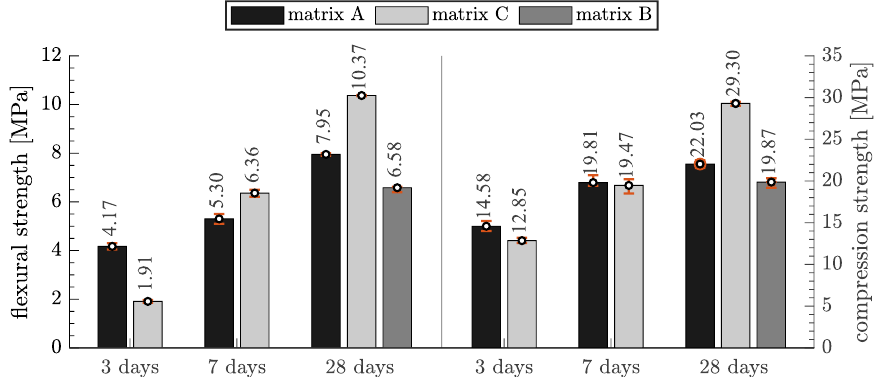
Figure 3. Flexural and compression strength of mortar matrices according to UNI EN 196-1.